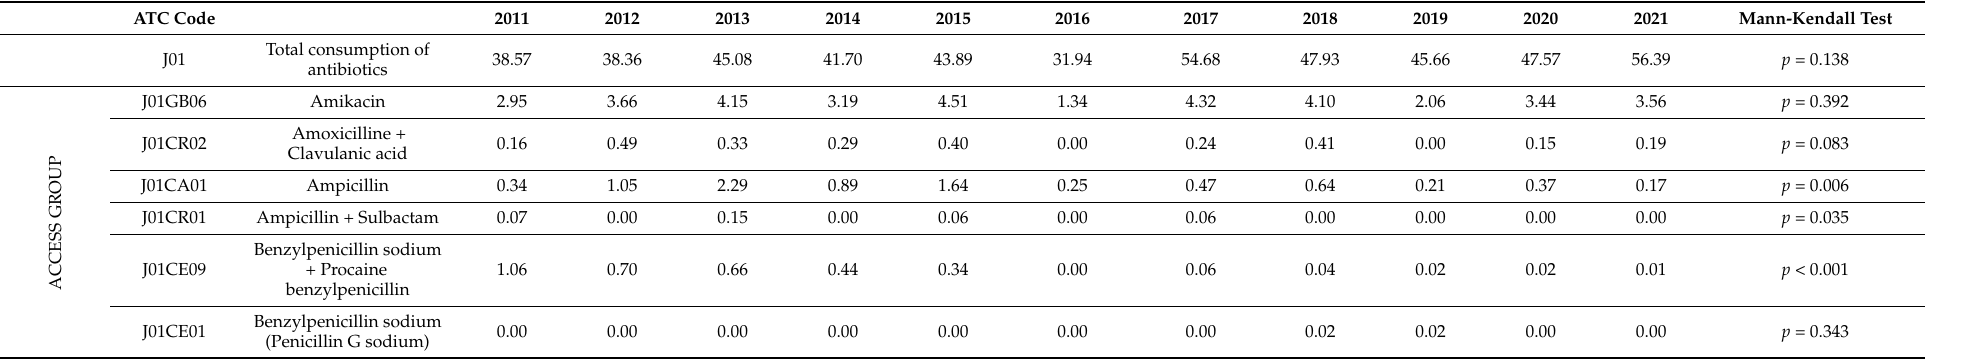
Table 2. Trends of antibiotic utilization over an 11-year period in the tertiary university hospital in Serbia according to WHO Access, Watch, and Reserve